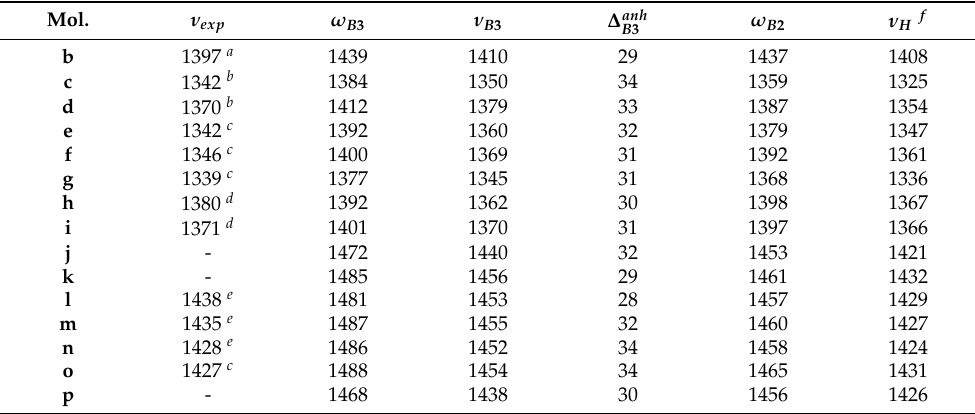
Table 4. Experimental vs. computed vibrational frequencies (cm − 1 ) for the NO stretching of different nitroxides labelled according to Figure 1.